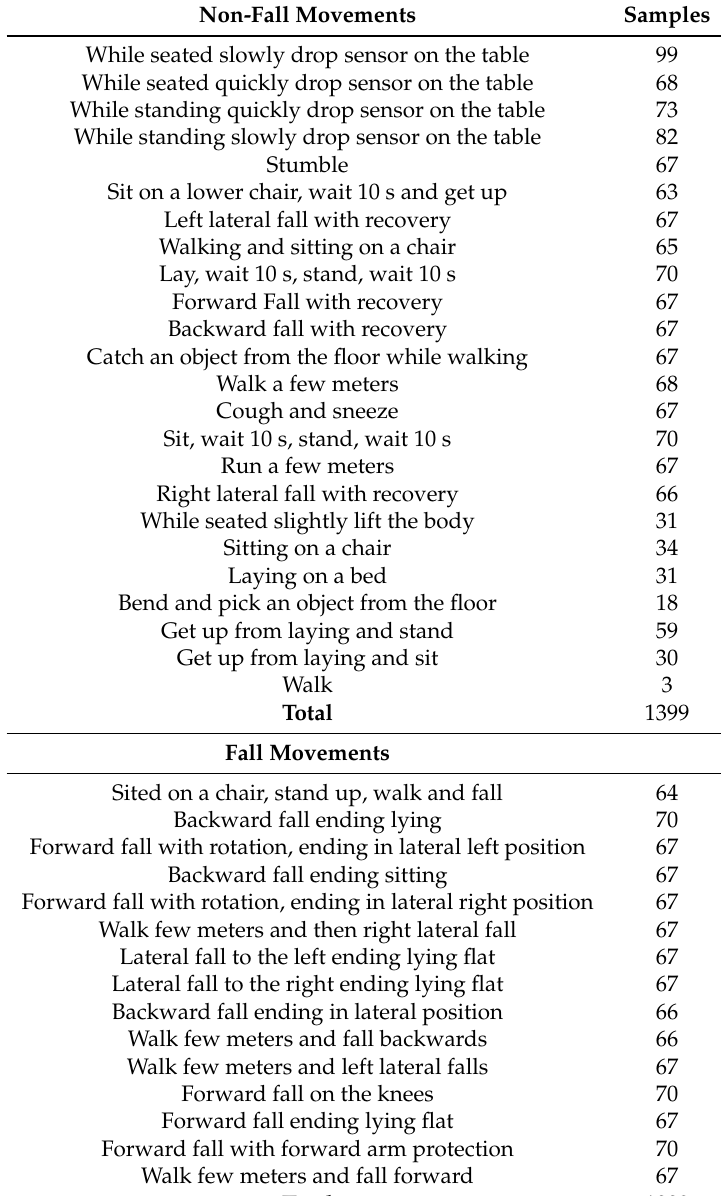
Table 1. Description of movements present on dataset DS-1